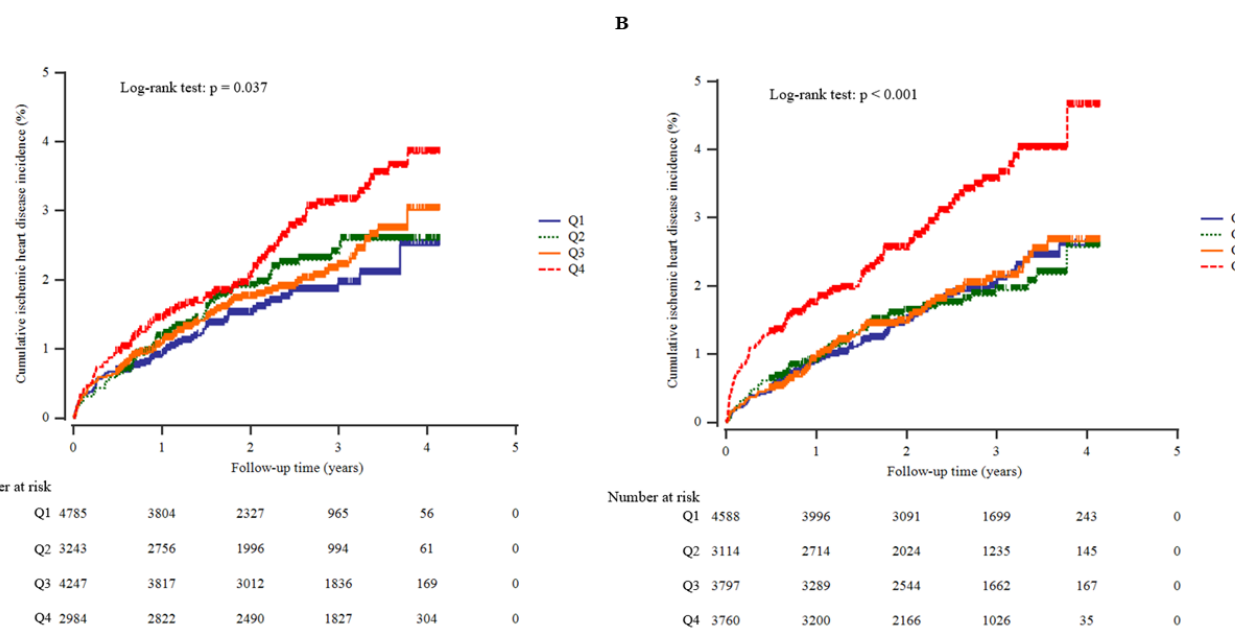
Figure 3. Trends in serum mineral levels according to age and Cox regression survival curves; serum calcium ( A , D ), phosphate ( B , E ), and calcium-to-phosphate ratio ( C , F ).